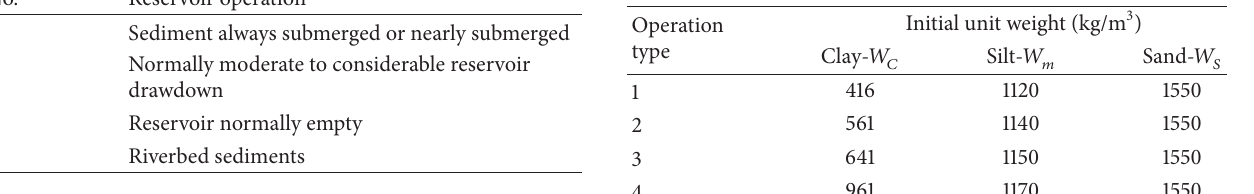
Table 2: Classification of reservoir operation [10]. Table 3: Initial unit weight of incoming sediments based on reservoir operation and type of sediments.